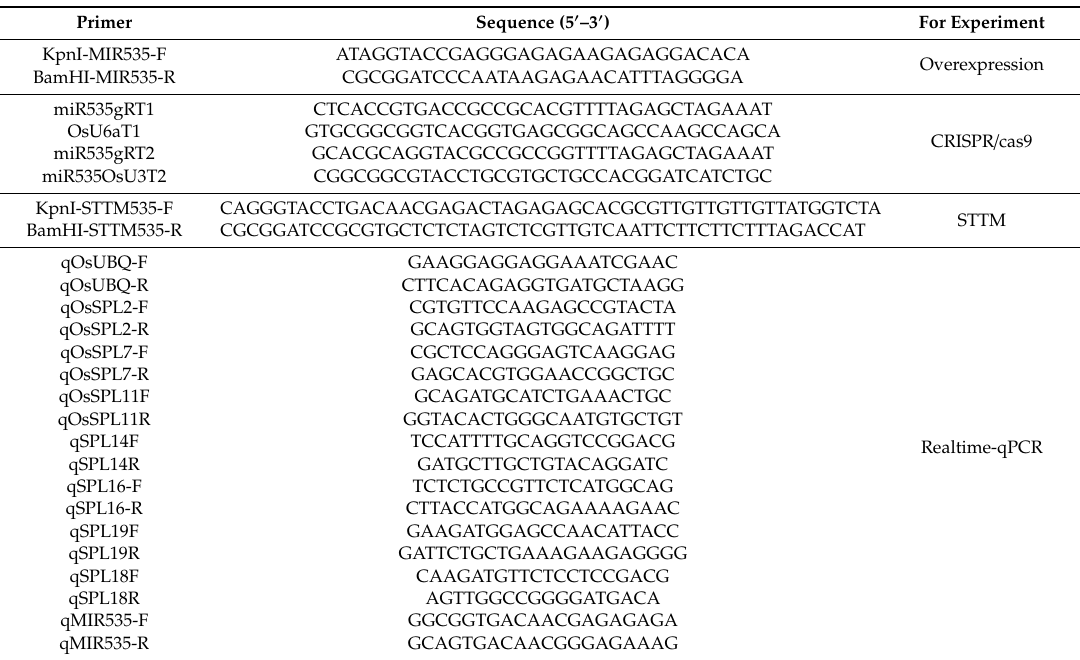
Table 1. The primers used in this